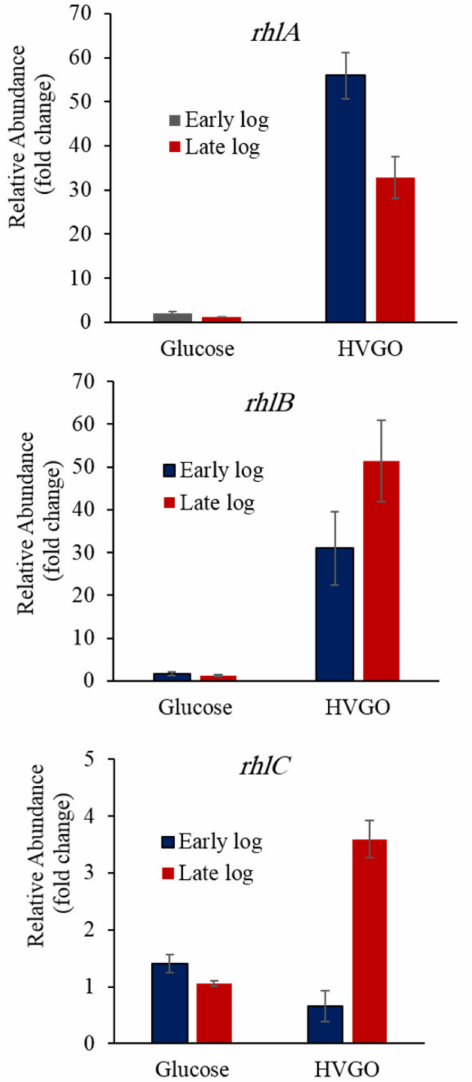
Figure 3. Relative expression of the rhlABC genes in the glucose and HVGO cultures of strain AK6U during the early and late log phases of growth. Error bars represent standard error (number of replicates =